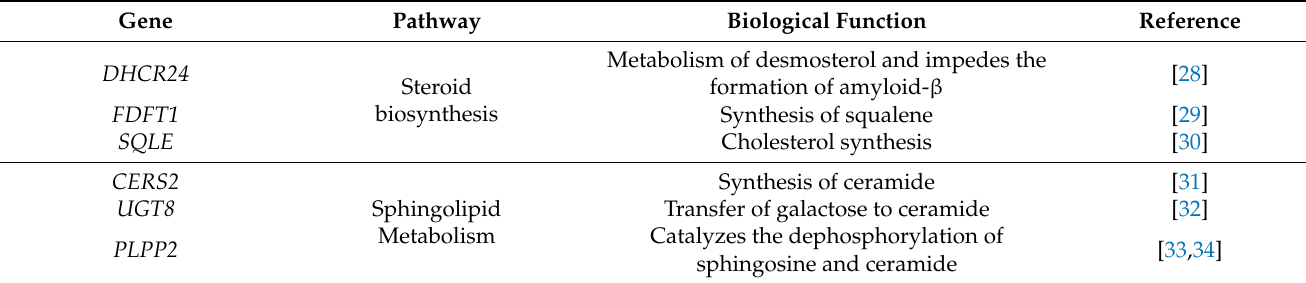
Table 2. Biological function of genes involved in enriched pathways and in common between YoungVsOAD, YoungVsOld, or